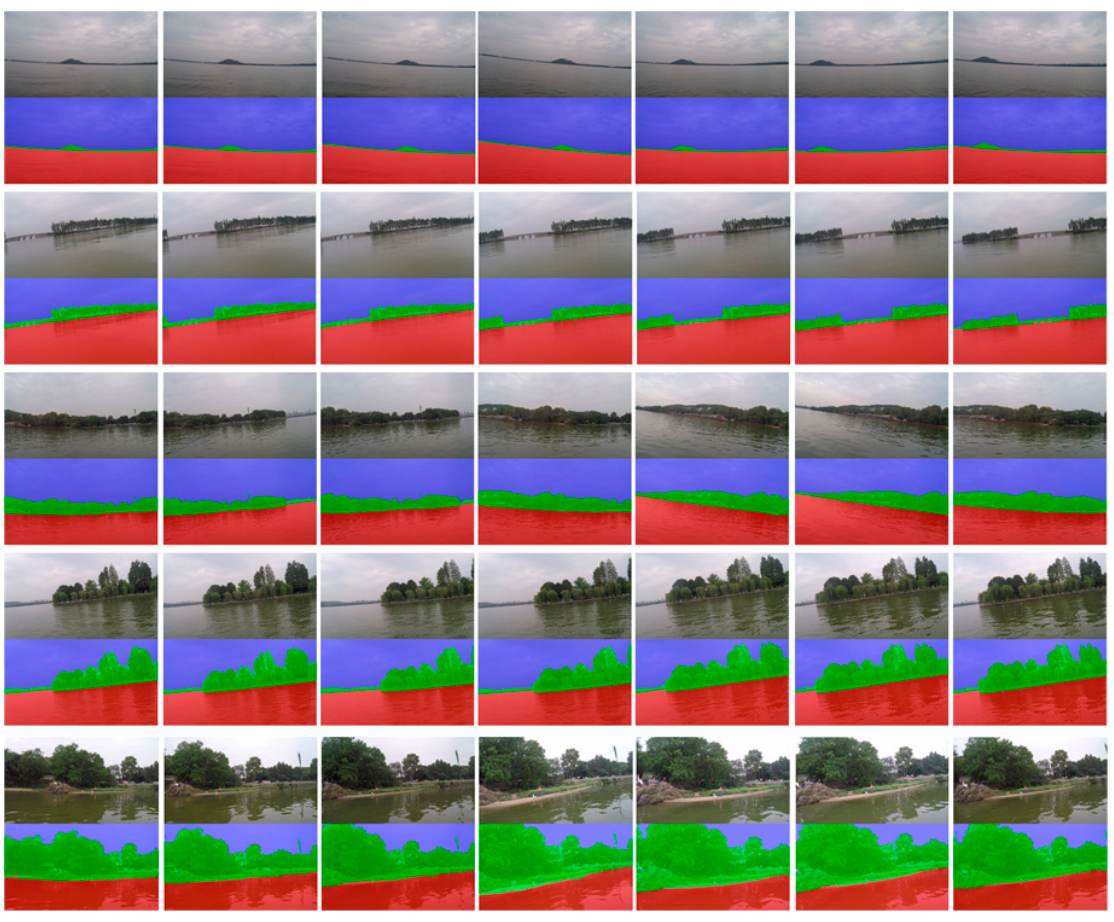
Figure 7. Experiment in di ff erent conditions.